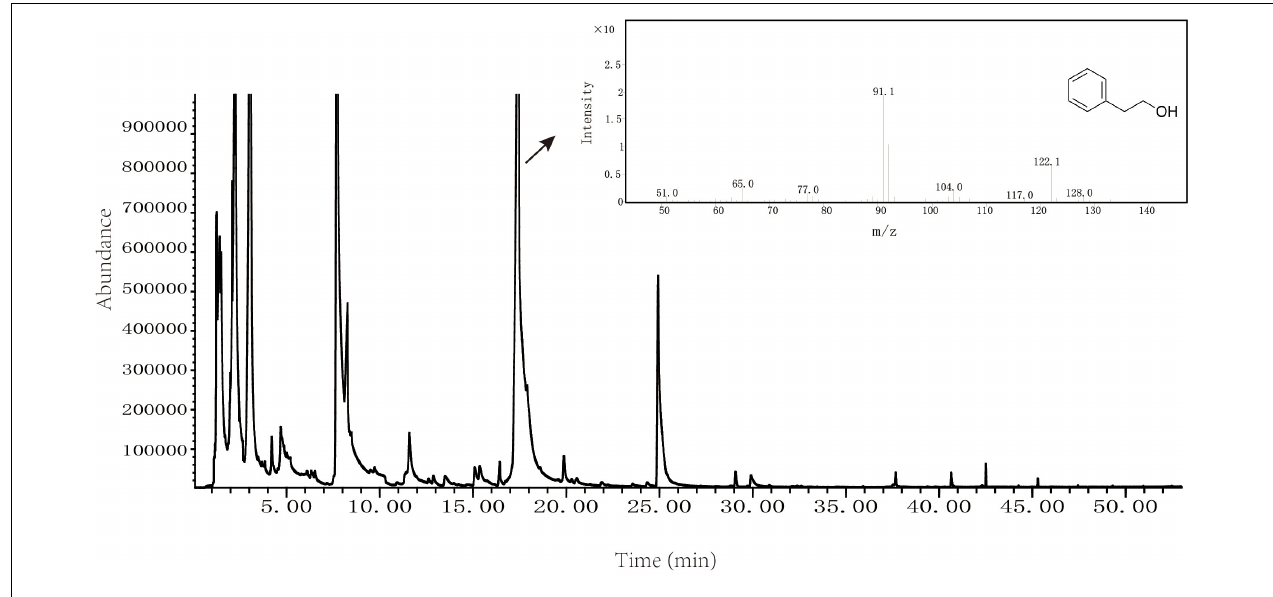
FIGURE 3 | Volatile flavor compounds produced by Z. rouxii